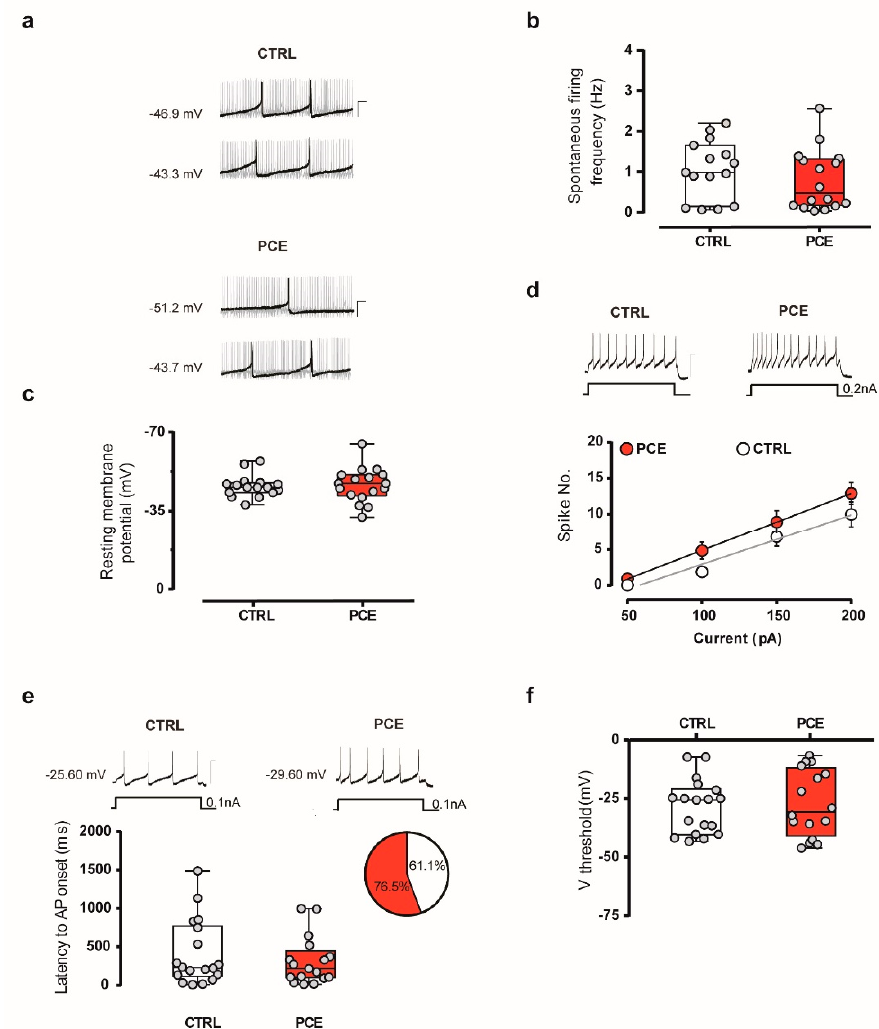
Figure 5. Intrinsic properties of putative VTA dopamine neurons are not affected by PCE in female preadolescent offspring. ( a ) Representative traces of spontaneous activity of dopamine neurons recorded from acute VTA slices from CTRL and PCE offspring ( n : 15 and 16 experiments from CTRL and PCE slices, respectively). Calibration bars, 100 ms, 20 mV. ( b , c ) PCE ( n cells = 16–17, n rats = 11/group) does not affect the spontaneous firing frequency ( b ) and resting membrane potential ( c ) compared with CTRL cells ( n cells = 15–16, n rats = 7/group). ( d ) Spike frequency in response to somatically injected current does not differ between CTRL ( n cells = 18, n rats = 7/group) and PCE ( n cells = 17, n rats = 11/group) offspring. Insets show representative traces of evoked action potentials (APs) in response to maximum current injected. Calibration bar, 200 ms, 100 mV. Data are represented as average values per animal ± s.e.m. ( e ) Top: representative traces of evoked APs in response to somatic current injection of 0.1 nA. Calibration bar, 100 ms, 50 mV. Bottom: latency to the first AP of dopamine neurons elicited in response to current injection of 0.1 nA is not modified by PCE. Inset shows a pie chart graph with the proportion of cells eliciting APs at 0.1 nA current (CTRL in white, PCE in red). ( f ) Threshold of AP elicited by depolarizing current does not vary between PCE ( n cells = 17, n rats = 11/group) and CTRL ( n cells = 18, n rats = 7/group) groups. Unless otherwise specified, all data are represented as box-and-whisker plots with single values (min to max).